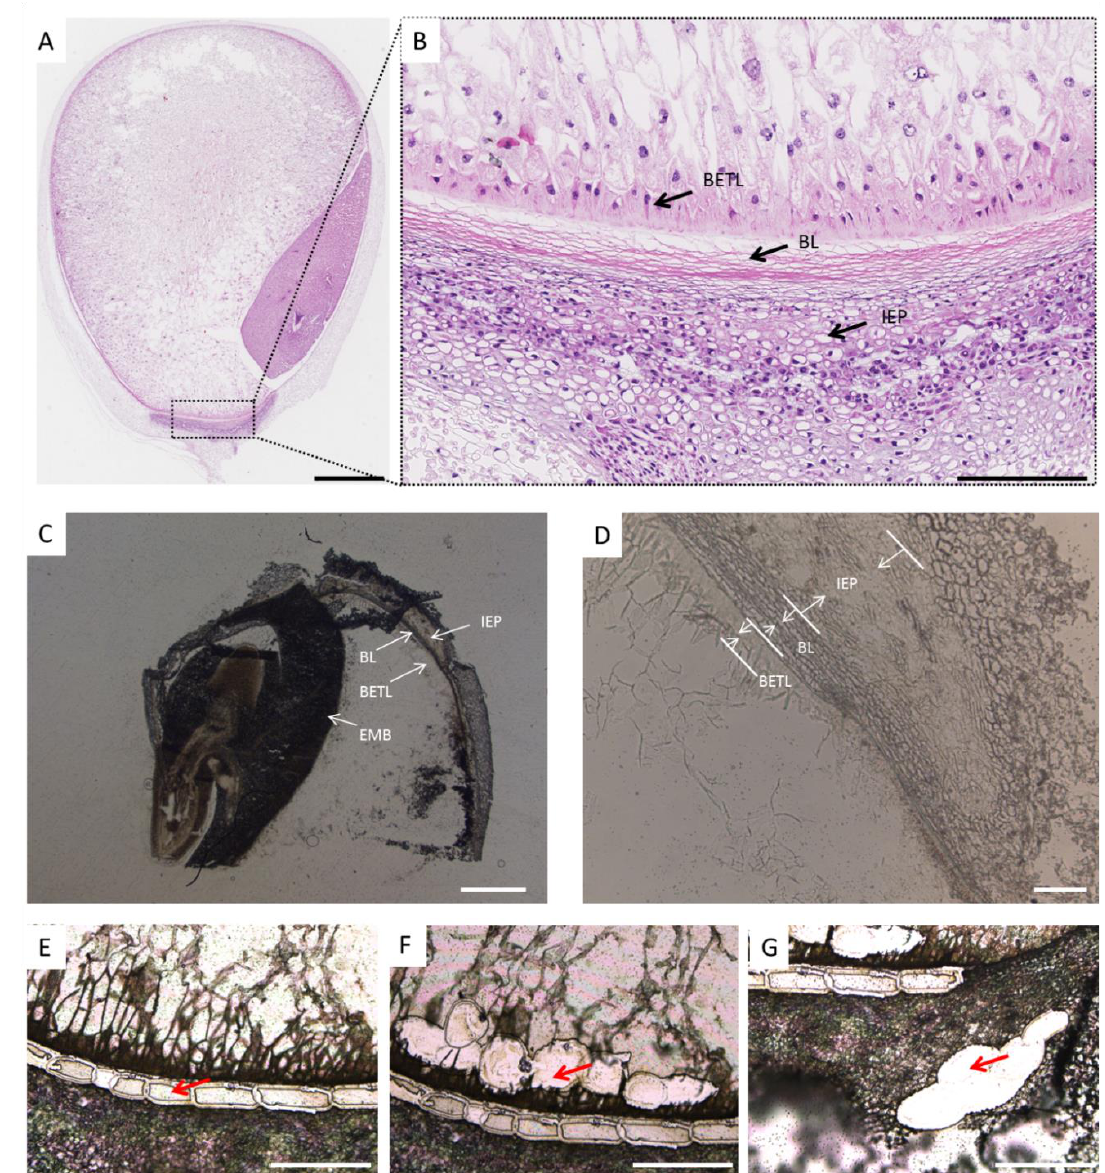
Figure 2. Isolation of the black layer (BL), inner epidermis of the pedicel (IEP), and basal endosperm transfer layer (BETL) from maize kernels 20 DAP by laser-capture microdissection. ( A ) Longitudinal paraffin sections of maize kernels 20 DAP. Bar = 1.25 mm; ( B ) High-magnification longitudinal sections of maize kernels 20 DAP. Arrows indicate the position of BL, IEP, and BETL. Bar = 200 μm; ( C ) and ( D ) Tissues from 8 μm thick cryosections before LCM cutting, showing the IEP, BL, BETL, and EMB. EMB, embryo. ( C ) Bar = 1000 μm. ( D ) Bar = 100 μm; ( E – G ) Tissues from 8 μm thick cryosections after LCM cutting. The red arrow indicates the successfully cut tissues of BL ( E ), BETL ( F ), and IEP ( G ). Bar = 200 μm.